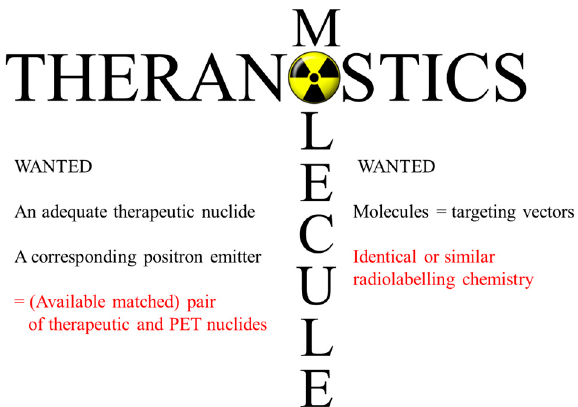
Figure 1. Nuclear and chemical components of radiotheranostics as a prerequisite to extract quantitative radiation doses (i.e., the optimum radioactivity of the radiotherapeutical to inject) for patient-individual treatment based on quantitative (PET) imaging.